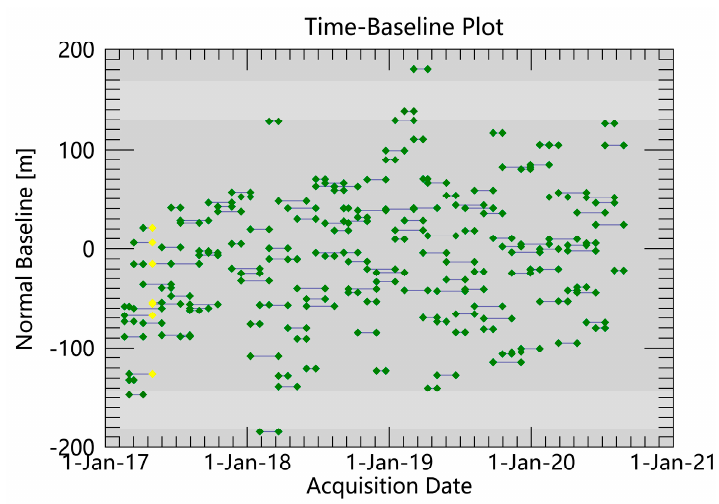
Figure 6. Time-Position map of Sentinel-1A ascending data.